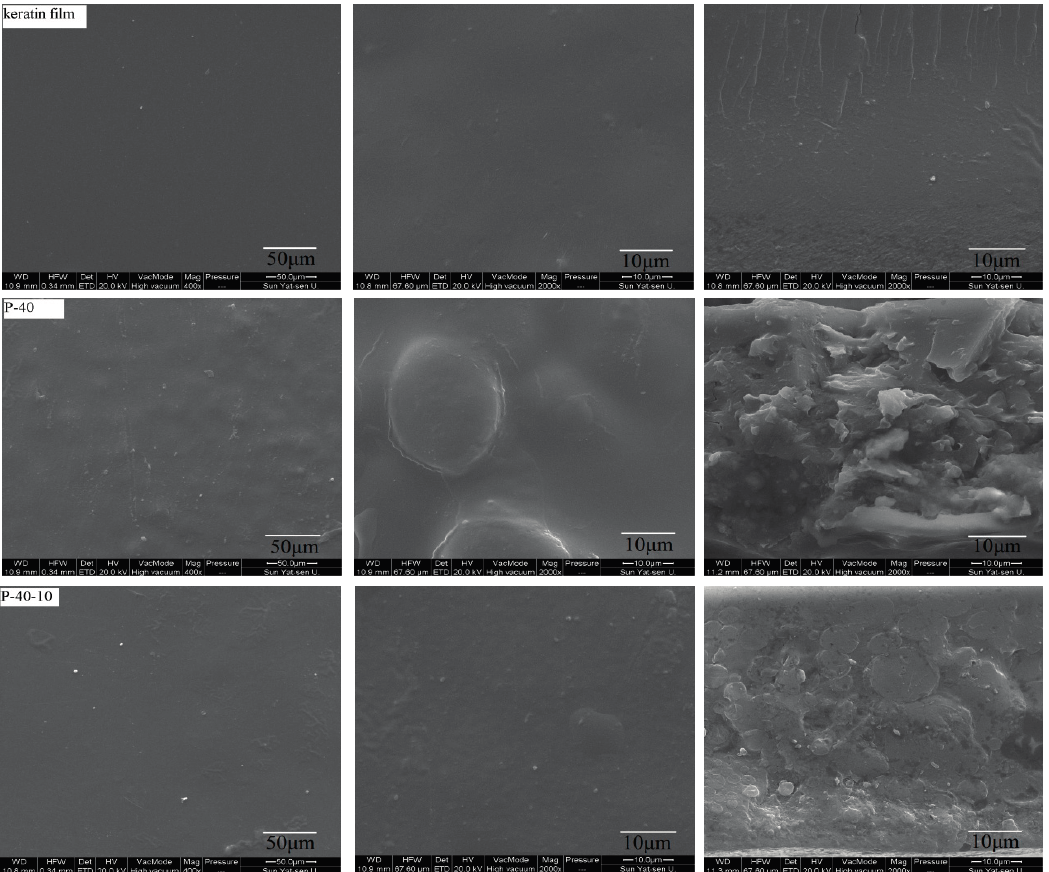
Figure 1. Representative SEM images revealing the surface morphology (left, 400×; center, 2000×) and the fracture morphology (right, 2000×) of the FK/PVA blend